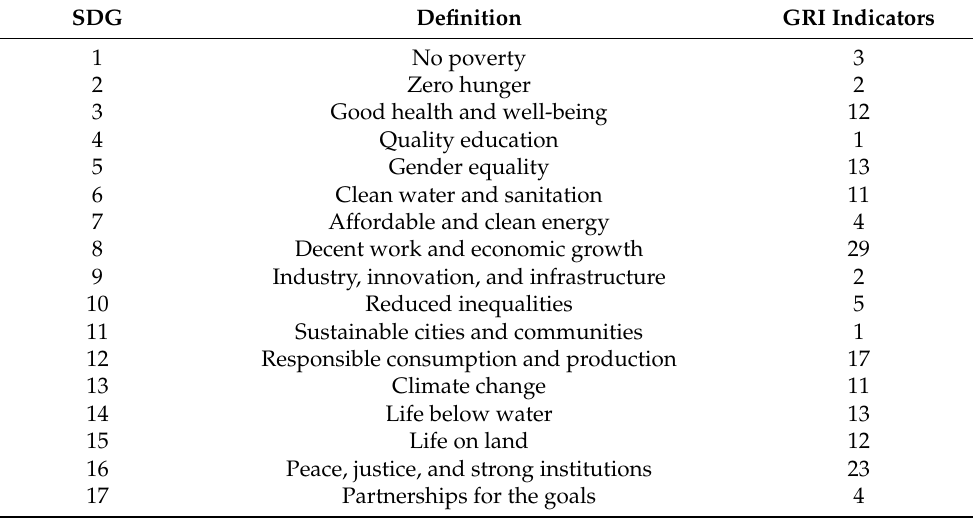
Table 1. Number of GRI indicators per